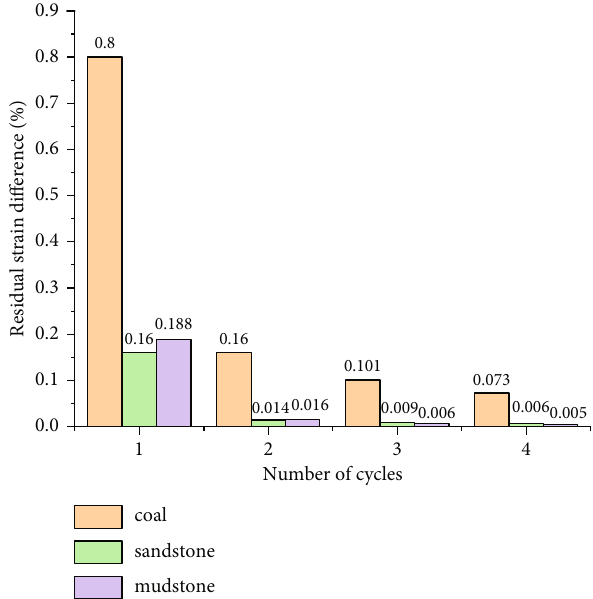
Figure 6: Residual strain di ff erence of di ff erent lithologies with number of cycles.